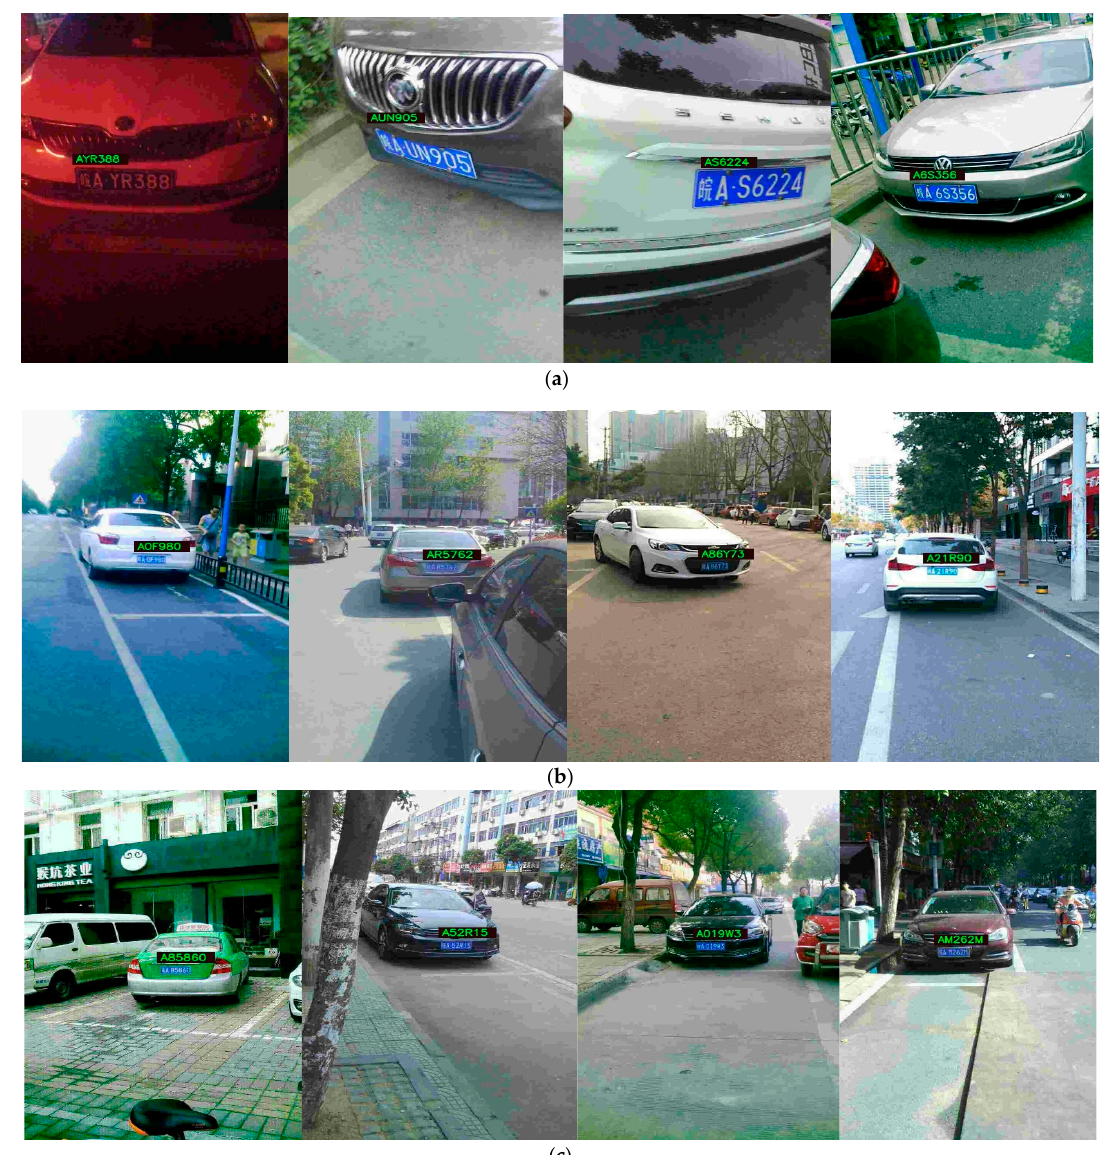
Figure 7 . The LPR on the CCPD dataset for ( a ) base, ( b ) blur, and ( c ) FN scenarios. Figure 7. The LPR on the CCPD dataset for ( a ) base, ( b ) blur, and ( c ) FN